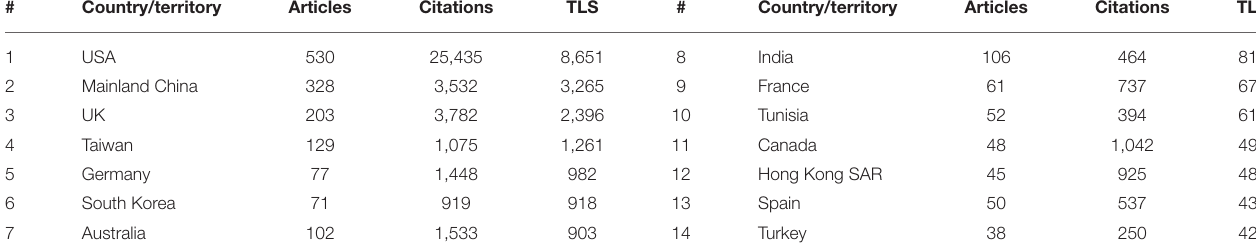
TABLE 3 | Country/territory-wise work done on IS.